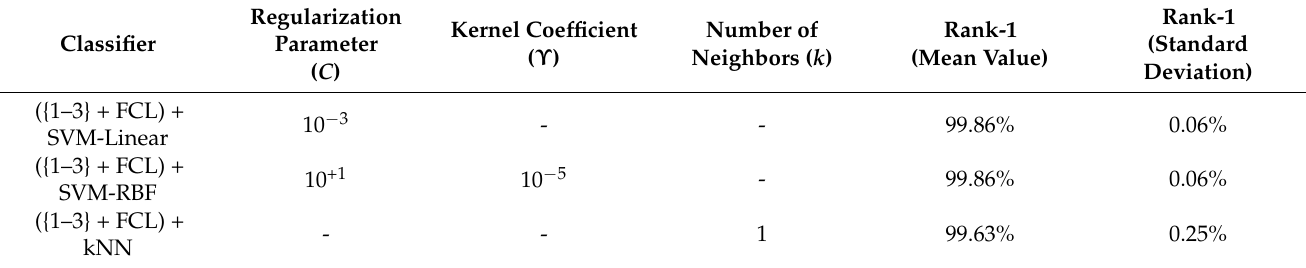
Table 3. Optimal values for each hyperparameter and its mean rank-1 and standard deviation using the CASIA NIR-VIS 2.0 database.